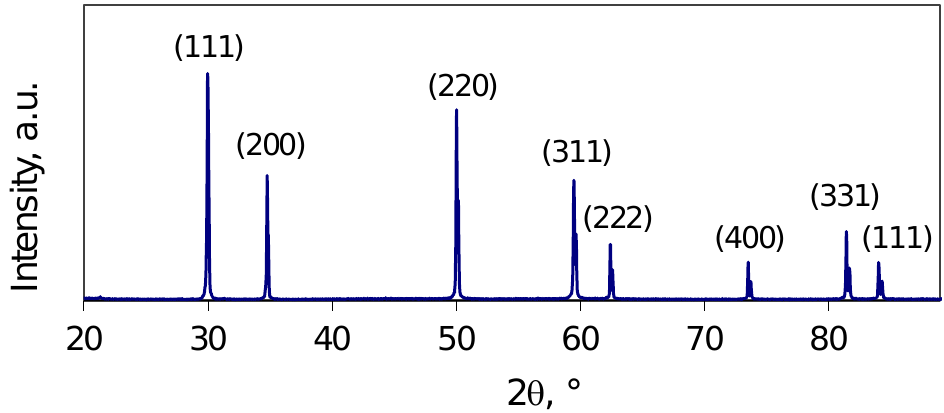
Figure 3. XRD patterns of YSZ sample.